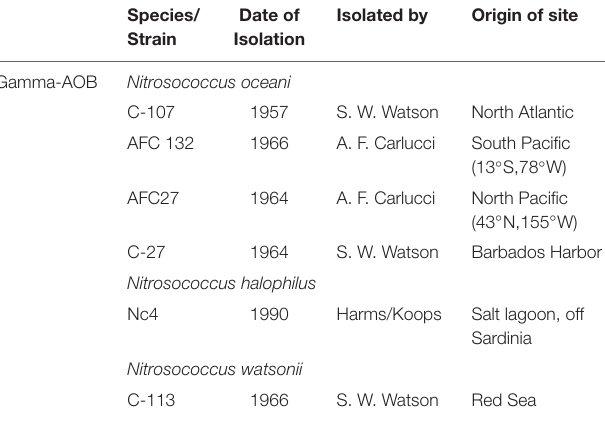
TABLE 1 | Genome-sequenced gammaproteobacterial AOB